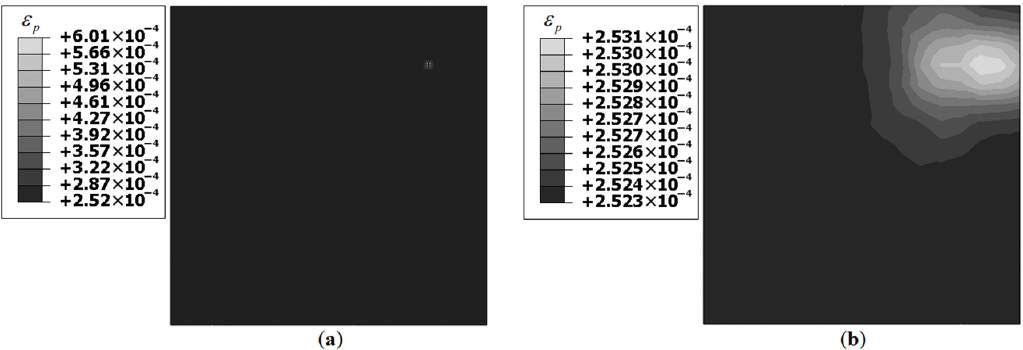
Figure 6. Contour plots of ε p for Damage Case-2: ( a ) FE results, and ( b ) benchmark iFEM results.